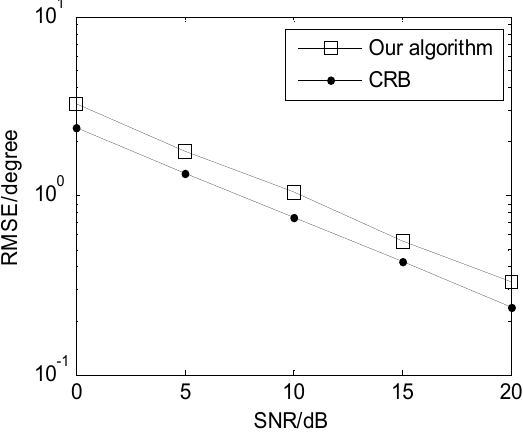
Figure 8. Angle estimation performance of our algorithm with different J . ( M = 12, and K = 3).